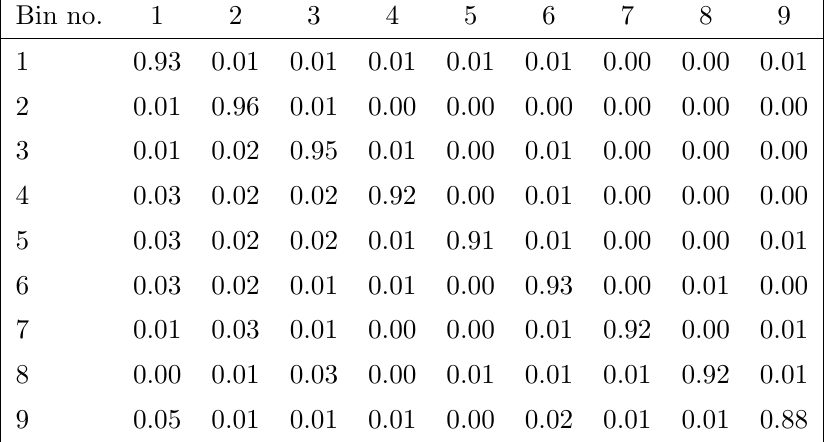
Table 13 . Migration matrix for B + ! D(cid:25) + decays estimated from the signal MC sample. The rows correspond to the true bins and columns show the reconstructed bins. Open